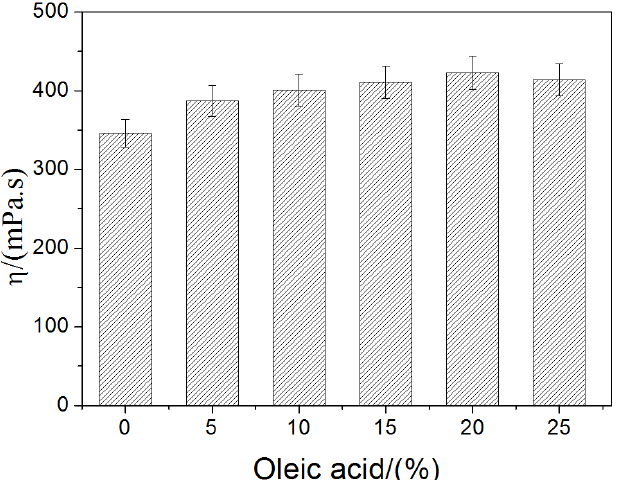
Figure 1. The effect of oleic acid on the viscosity of film forming emulsions.